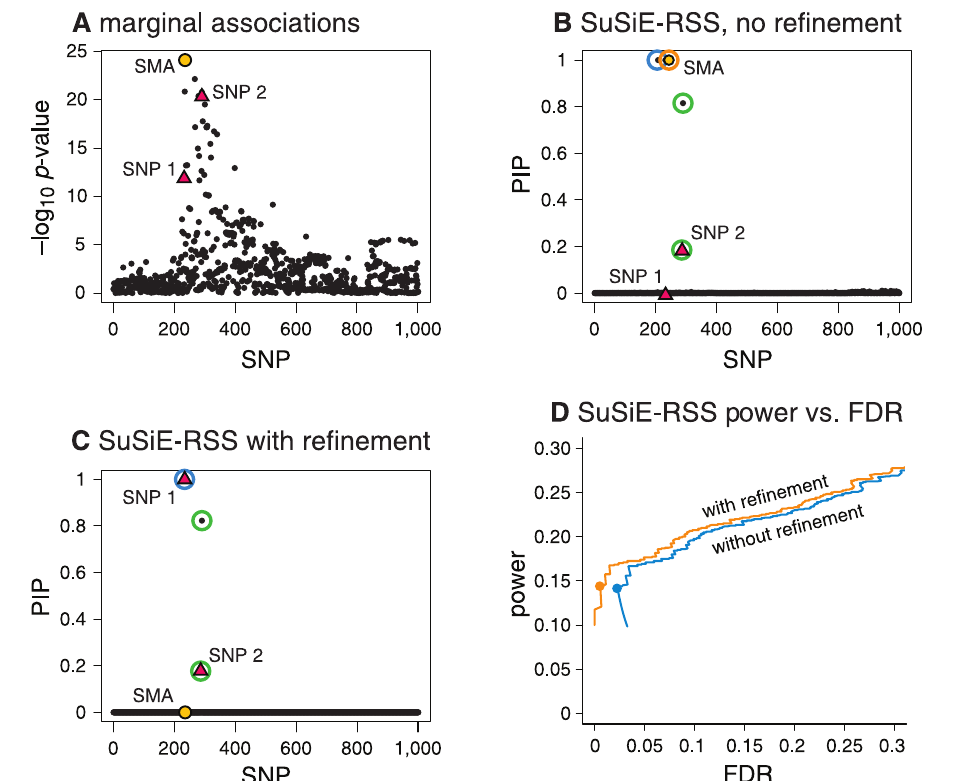
Fig 2. Refining SuSiE model fits improves fine-mapping accuracy. Panels A, B and C show a single example, drawn from our simulations, that illustrates how refining a SuSiE-RSS model fit improves fine-mapping accuracy. In this example, there are 1,001 candidate SNPs, and two SNPs (red triangles “SNP 1” and “SNP 2”) explain variation in the simulated phenotype. The strongest marginal association (yellow circle, “SMA”) is not a causal SNP. Without refinement, the IBSS-ss algorithm (applied to sufficient statistics, with estimated σ 2 ) returns a SuSiE-RSS fit identifying three 95% CSs (blue, green and orange circles); two of the CSs (blue, orange) are false positives containing no true effect SNP, one of these CSs contains the SMA (orange), and no CS includes SNP 1. After running the refinement procedure, the fit is much improved, as measured by the “evidence lower bound” (ELBO); it increases the ELBO by 19.06 ( − 70837.09 vs. − 70818.03). The new SuSiE-RSS fit (Panel C) identifies two 95% CSs (blue and green circles), each containing a true causal SNP, and neither contains the SMA. Panel D summarizes the improvement in fine-mapping across all 600 simulations; it shows power and false discovery rate (FDR) for SuSiE-RSS with and without using the refinement procedure as the PIP threshold for reporting causal SNPs is varied from 0 to 1. (This plot is the same as a precision-recall curve after flipping the x-axis because precision ¼ TP ¼ 1 (cid:0) FDR and recall = power.) Circles are TP þ FP drawn at a PIP threshold of